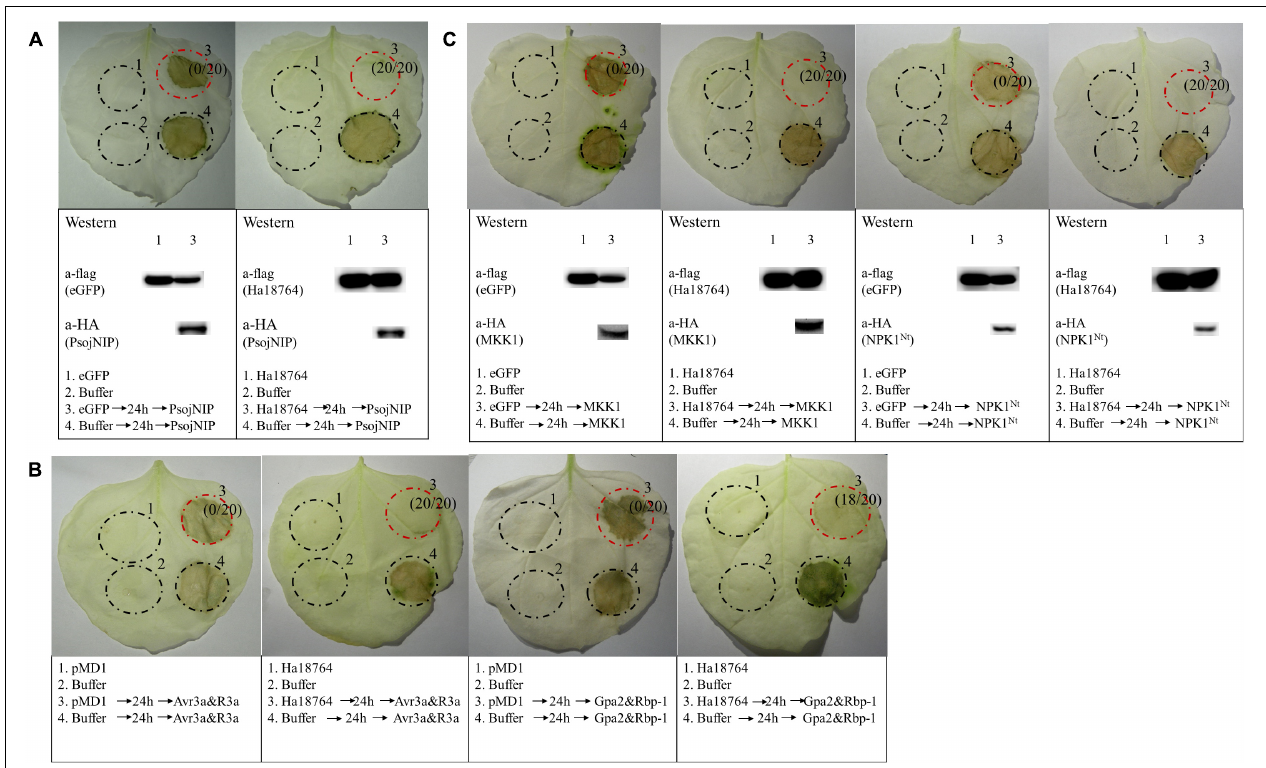
FIGURE 6 | Ha18764 suppresses immune-associated cell death. (A) Ha18764 suppressed PsojNIP-triggered cell death. (B) Ha18764 suppressed the cell death triggered by either Avr3a/R3a or Gpa2/RBP-1. The empty pMD1 vector served as a negative control. (C) Ha18764 suppressed MAPK cascade-associated cell death. Nicotiana benthamiana leaves were infiltrated with buffer or Agrobacterium tumefaciens cells carrying Ha18764 or the negative control, either alone or 24 h prior to infiltration with A. tumefaciens cells carrying the elicitors. Photographs of infiltrated leaves were taken ca. 4 days after the last infiltration. Four circles marked with Roman numerals represented regions injected with different A. tumefaciens , which is indicated under the photographs. The numbers in parentheses indicate the proportion of infiltrated sites showing cell-death-suppressing symptoms. The original Western blotting images for the verification of gene expression were provided in Supplementary Figures S3 , S4